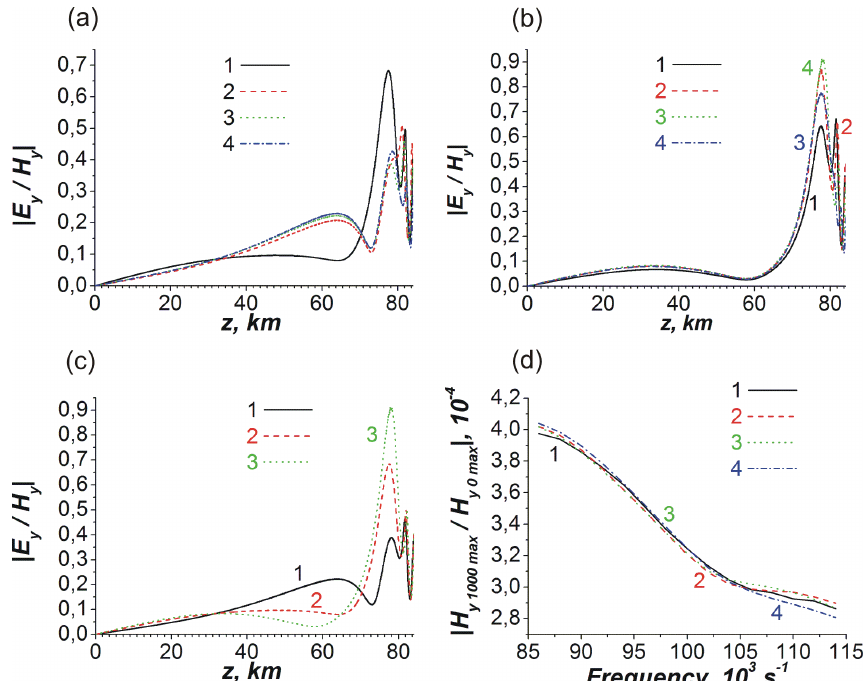
Figure 8. Characteristics of the polarization transformation parameter | E y /H y | (a–c) and the effective coefficient of the total losses at the distance of x 0 = 1000km from the beam input (d) . Corresponding altitude dependence of the electron concentration is shown in line 1 of Fig. 5b. Panels (a) , (b) and (d) show dependences of the polarization parameter (a, b) and total losses (d) on the vertical coordinate and frequency for different θ angles, respectively. Black (1), red (2), green (3) and blue (4) curves in panels (a) , (b) and (d) correspond to 5, 30, 45 and 60 ◦ , respectively. Panels (a) and (b) correspond to the frequencies ω = 0 . 86 × 10 5 s − 1 and ω = 1 . 14 × 10 5 s − 1 , respectively. Panel (c) shows the dependence of the polarization parameter on the vertical coordinate for the different frequencies. Black (1), red (2) and green (3) lines correspond to the frequencies 0 . 86 × 10 5 , 1 × 10 5 and 1 . 14 × 10 5 s − 1 , respectively, and θ = 45 ◦ .